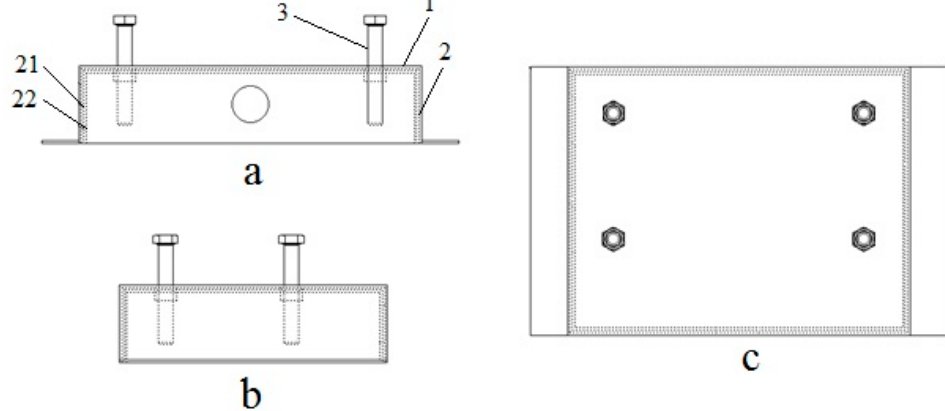
Figure 6. Schematic diagram of a three-dimensional structure of a sound insulation cabin: Front view ( a ), side view ( b ) and top view ( c ), where 21 and 22 represent a sound insulation and 3 is used to fix the acoustic emission (AE) sensors.